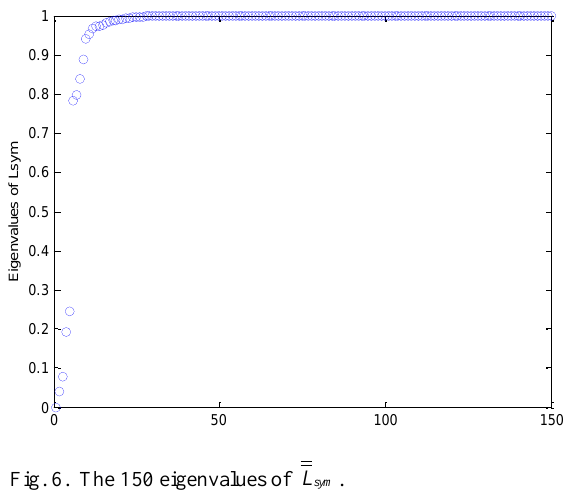
Fig. 6. The 150 eigenvalues of sym L .